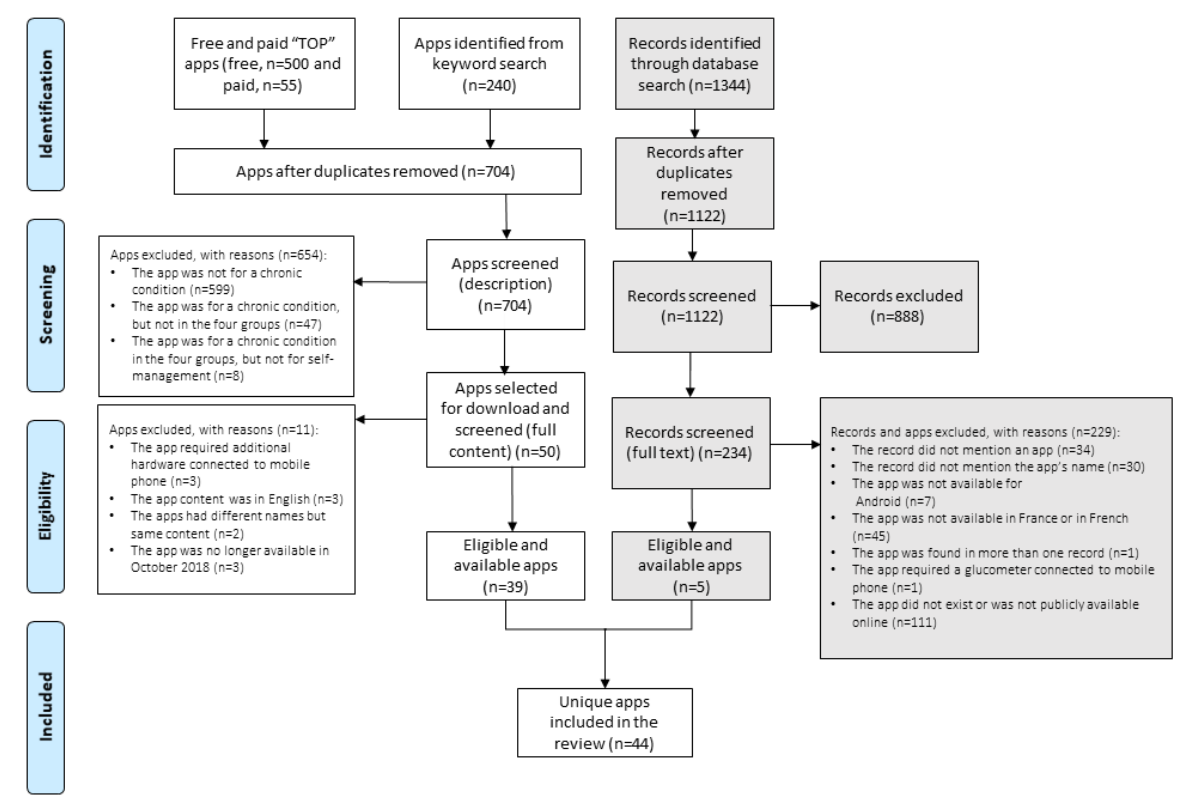
Figure 1. Flowchart of the screening